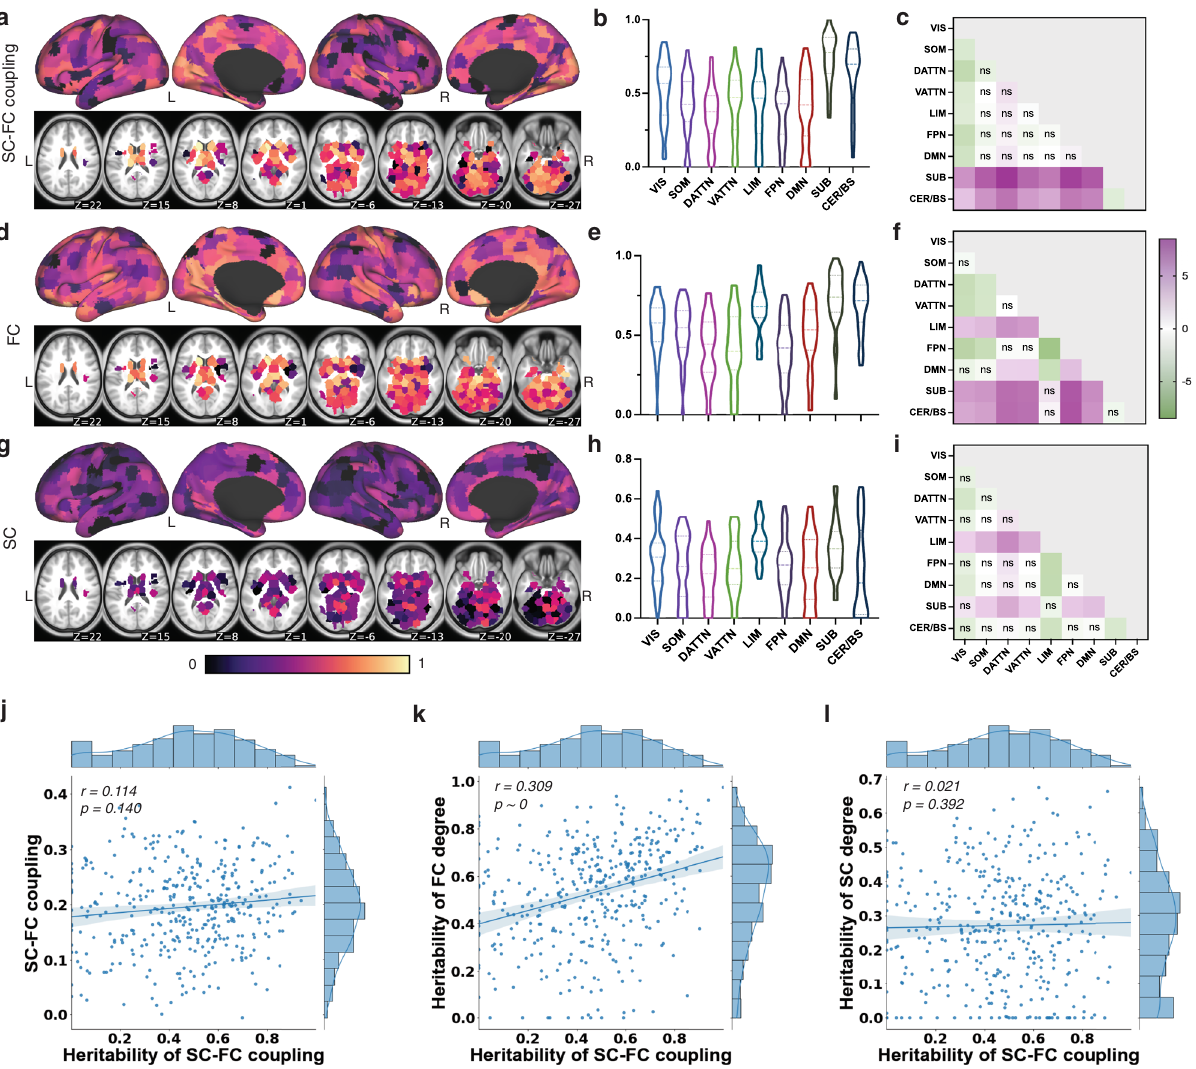
Fig. 5 SC – FC coupling heritability estimates. a , d , and g Regional heritability estimates of SC – FC coupling, SC node strength and FC node strength. b , e , and h Regional heritability estimates of SC – FC coupling, grouped by functional network, for SC – FC coupling, SC node strength and FC node strength, respectively. c , f , and i show the t -statistics for all pairwise comparisons of heritability across networks, calculated as the network on the y -axis versus the network on the x -axis. One-sided p -values were calculated (see detailed description in the “ Methods ” section). Those comparisons with FDR corrected p > 0.05 are marked with ns . j SC – FC coupling heritability has a weak, positive correlation with its signal strength (Pearson ’ s r = 0.114, uncorrected p = 0.140). k and l Regional heritability estimates of SC – FC coupling are moderately positively correlated with regional heritability of FC node strength (Pearson ’ s r = 0.309, uncorrected p = 0) and are not correlated with regional heritability of SC node strength (Pearson ’ s r = 0.021, uncorrected p = 0.392). The translucent bands around the regression line represent 95% con fi dence interval for the regression